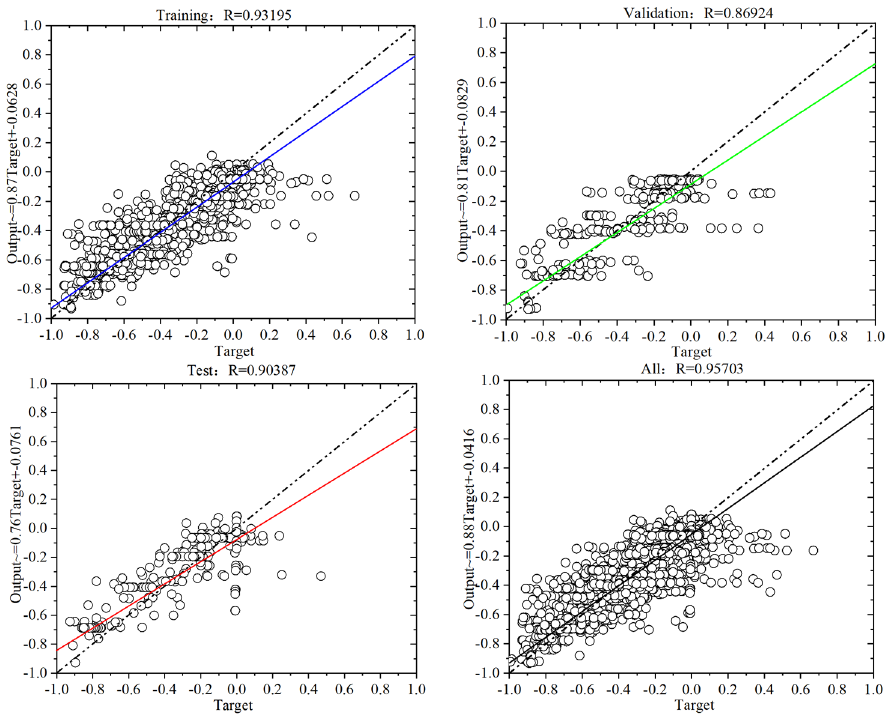
Figure 7. Correlation of PSO-BP modeling.